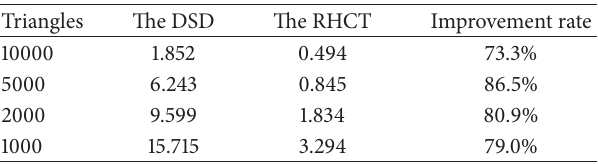
Table 2: RMS error comparison for simplifying camel animation model (unit: 10 − 3 ).